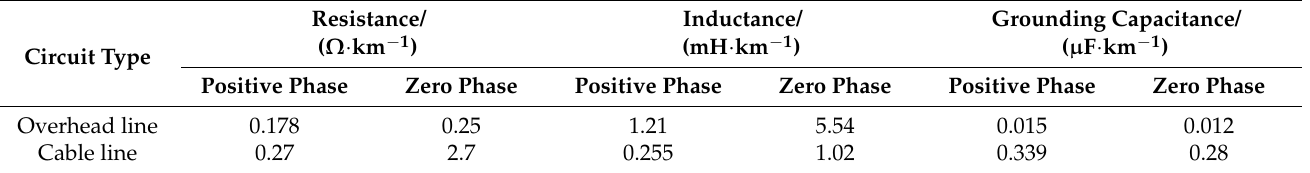
Figure 13. Distribution network Recurrence Plot.